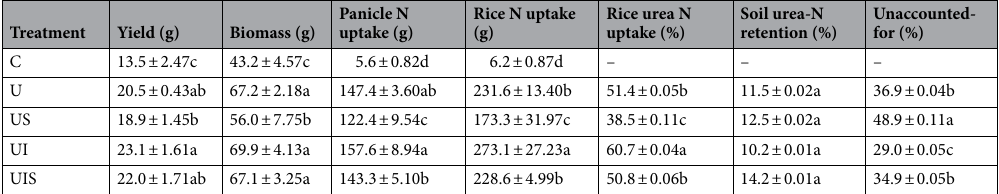
Table 3. Rice yield, biomass, nitrogen content assimilated from urea and the fate of urea-derived N at harvest (% of applied N). C: no nitrogen, inhibitor and straw; U: 15 N labeled urea; US: 15 N labeled urea + straw; UI: 15 N labeled urea + inhibitor; UIS: 15 N labeled urea + inhibitor + straw. The values in the table represent the mean of three replicates. Different lowercase letters represent significant differences among treatments during the same sampling period (Duncan, P < 0.05).